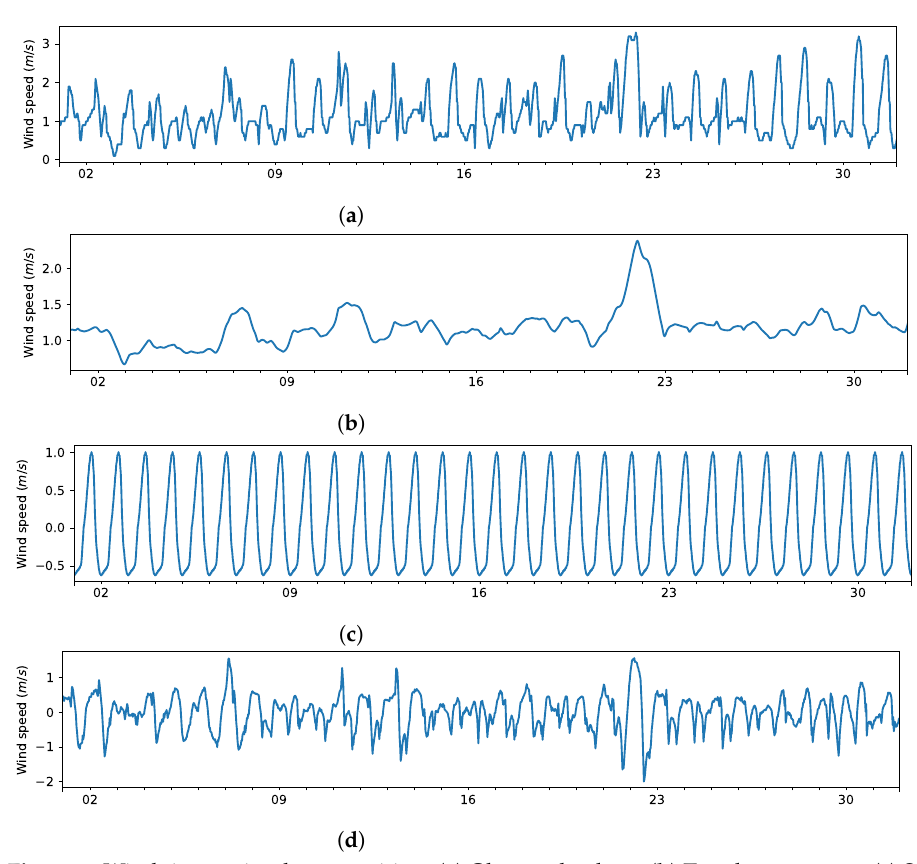
Figure 7. Wind time series decomposition. ( a ) Observed values. ( b ) Trend component. ( c ) Seasonal component. ( d ) Residual